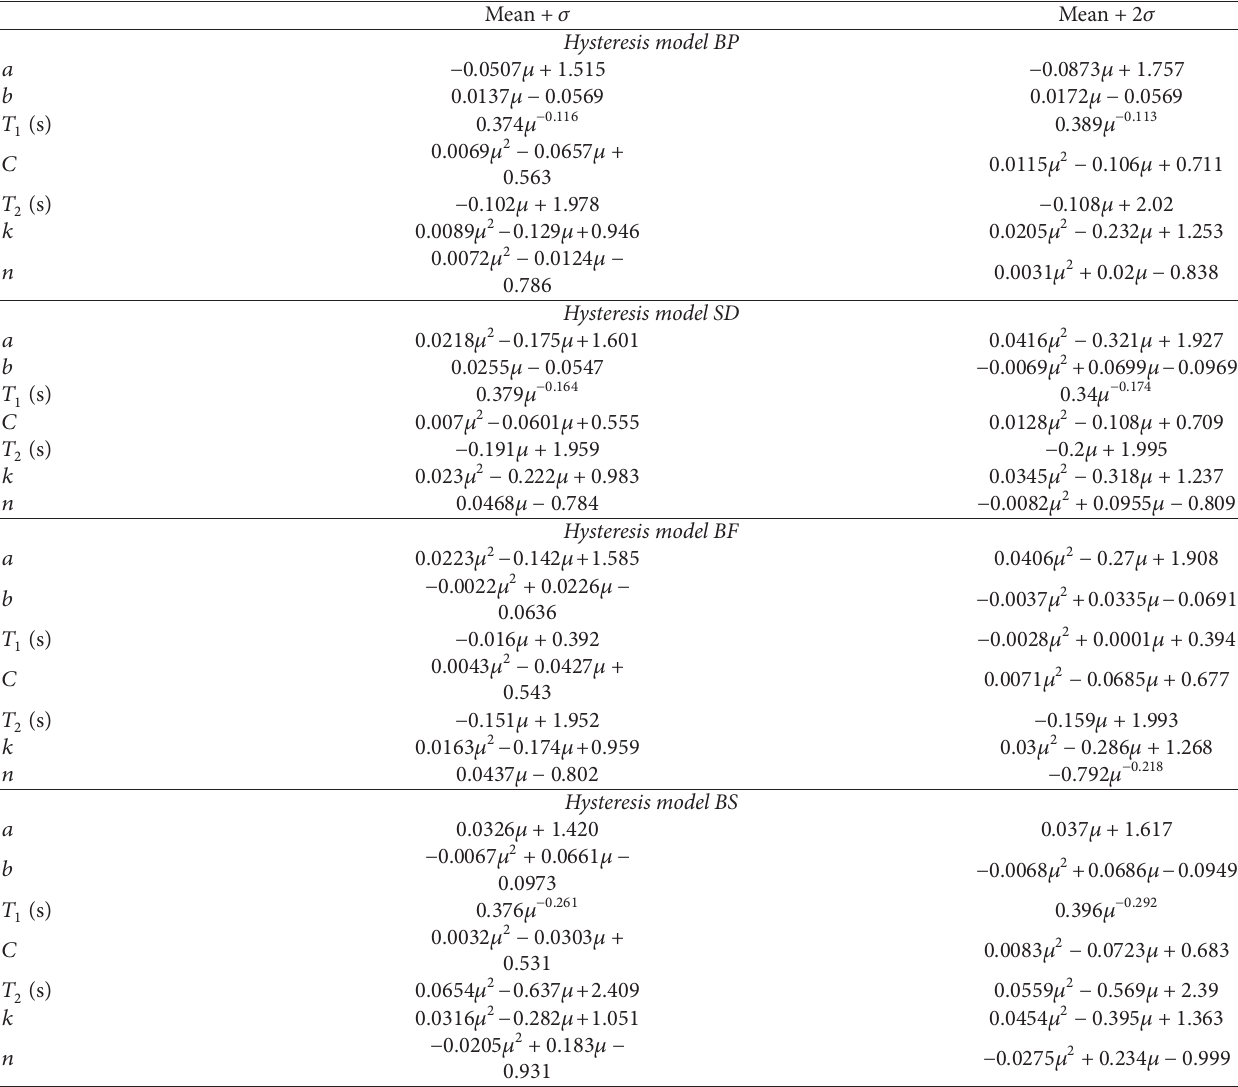
Table 7: Normalized input energy spectral shape parameters (site class